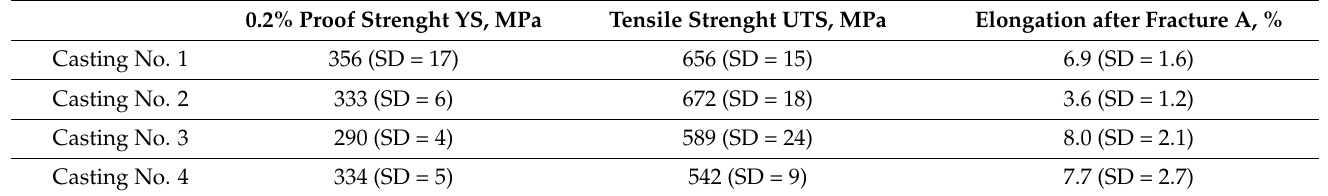
Table 3. Tensile test results of the specimens from the examined castings (average of 3 results).